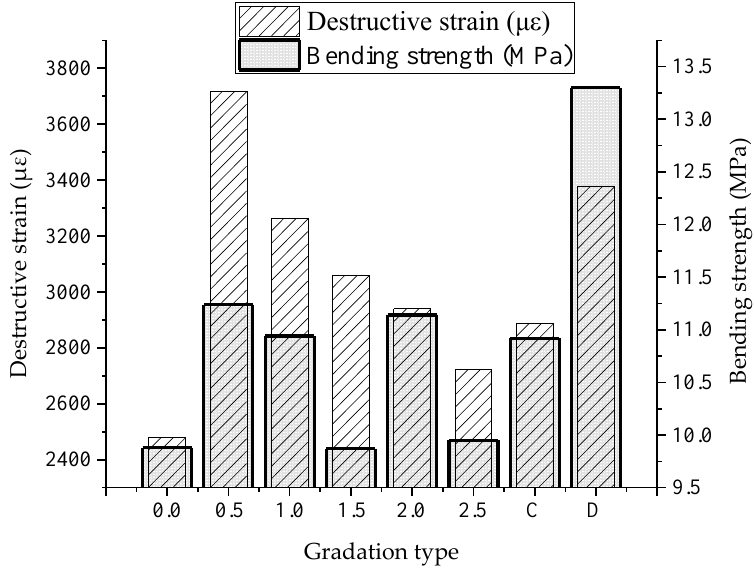
Figure 8. Low-temperature test results for different mixture types.